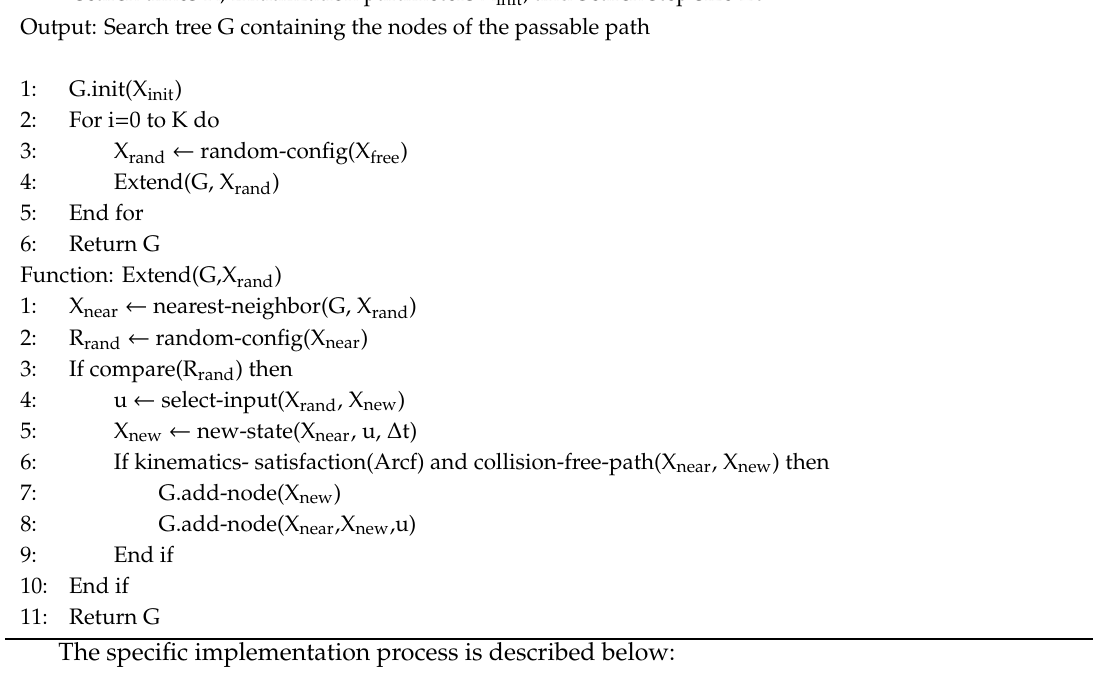
Algorithm 1. Pseudocode for RRT Algorithm with Kinematic